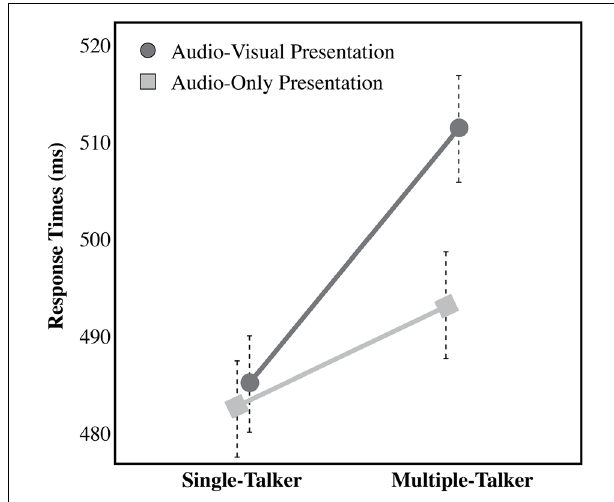
FIGURE 2 | Response times (RTs) for the single-talker and multiple-talker conditions for both presentation modalities (audio-only and audio-visual). Error bars represent 1